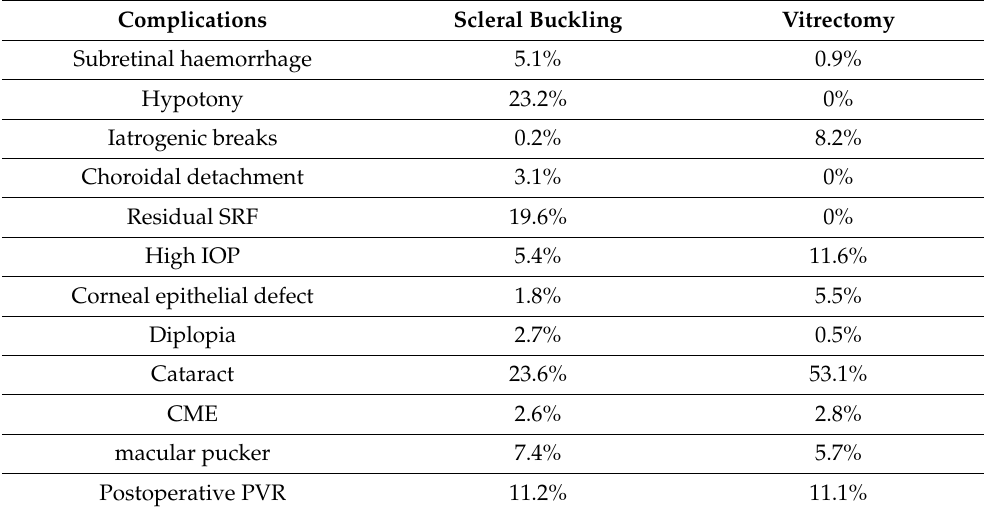
Table 1. Pooled rate of surgical complications after scleral buckling and vitrectomy for rhegmatoge- nous retinal detachment. Data from Lv et al. 2015